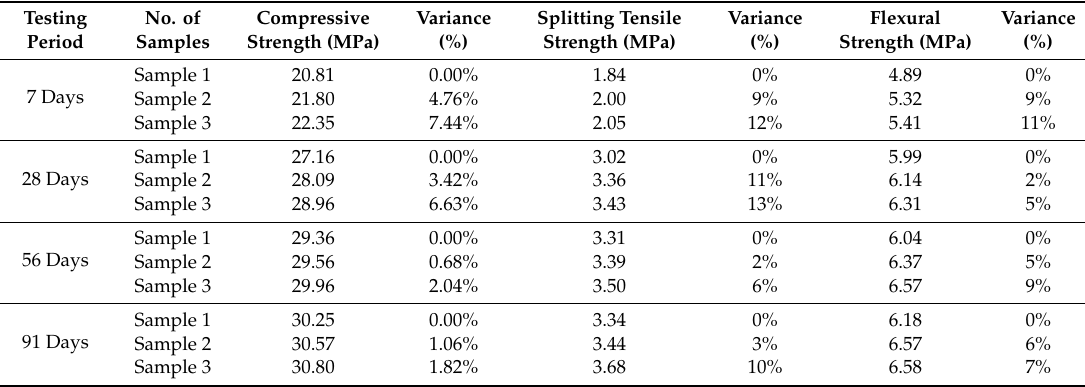
Table 6. Variance of results in one batch (M-1).